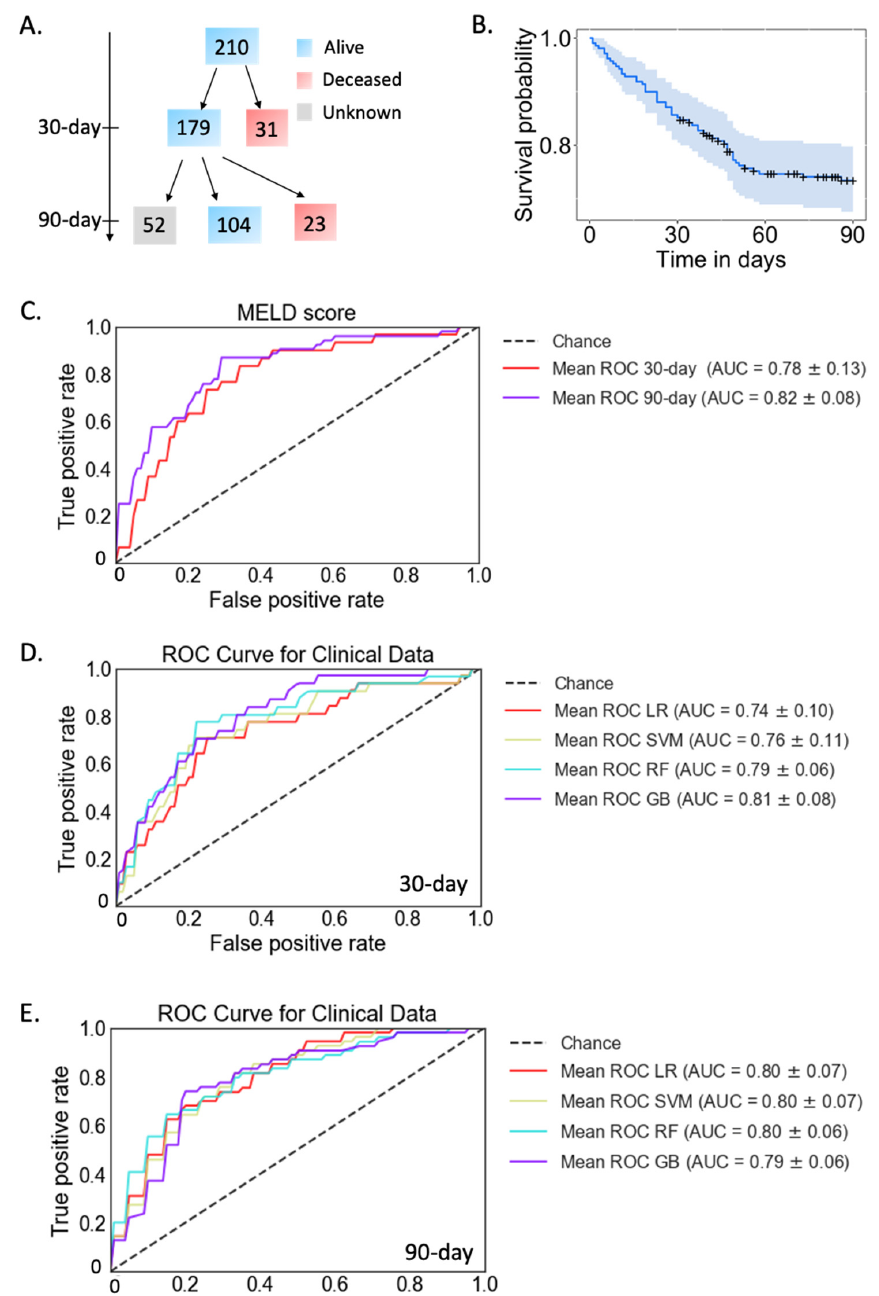
Figure 1. Mortality prediction with clinical parameters in patients with alcoholic hepatitis. ( A ) A total of 210 patients were included in this study. 31 died within 30-day and 179 patients were alive, 23 patients died within 90 days. A total of 104 patients survived at 90 days. The remaining 52 patients were lost to follow-up. Blue: alive. Red: deceased. Grey: unknown status. ( B ) Survival probability within 90 days. Confidence intervals are shown in light blue. +: Patients lost to follow-up were censored at the time they were last seen alive. ( C ) Prediction of 30-day (red line, AUC = 0.78) and 90-day mortality using MELD score (purple line, AUC = 0.82). ( D ) Four models for 30-day mortality prediction in patients with alcoholic hepatitis using clinical data. Day-30 deceased group n = 31, alive group n = 179. ( E ) Four models for 90-day mortality prediction in patients with alcoholic hepatitis using clinical data. Day-90 deceased group n = 54, alive group n = 104. GB: gradient boosting, LR: logistic regression, RF: random forest, SVM: support vector machine.